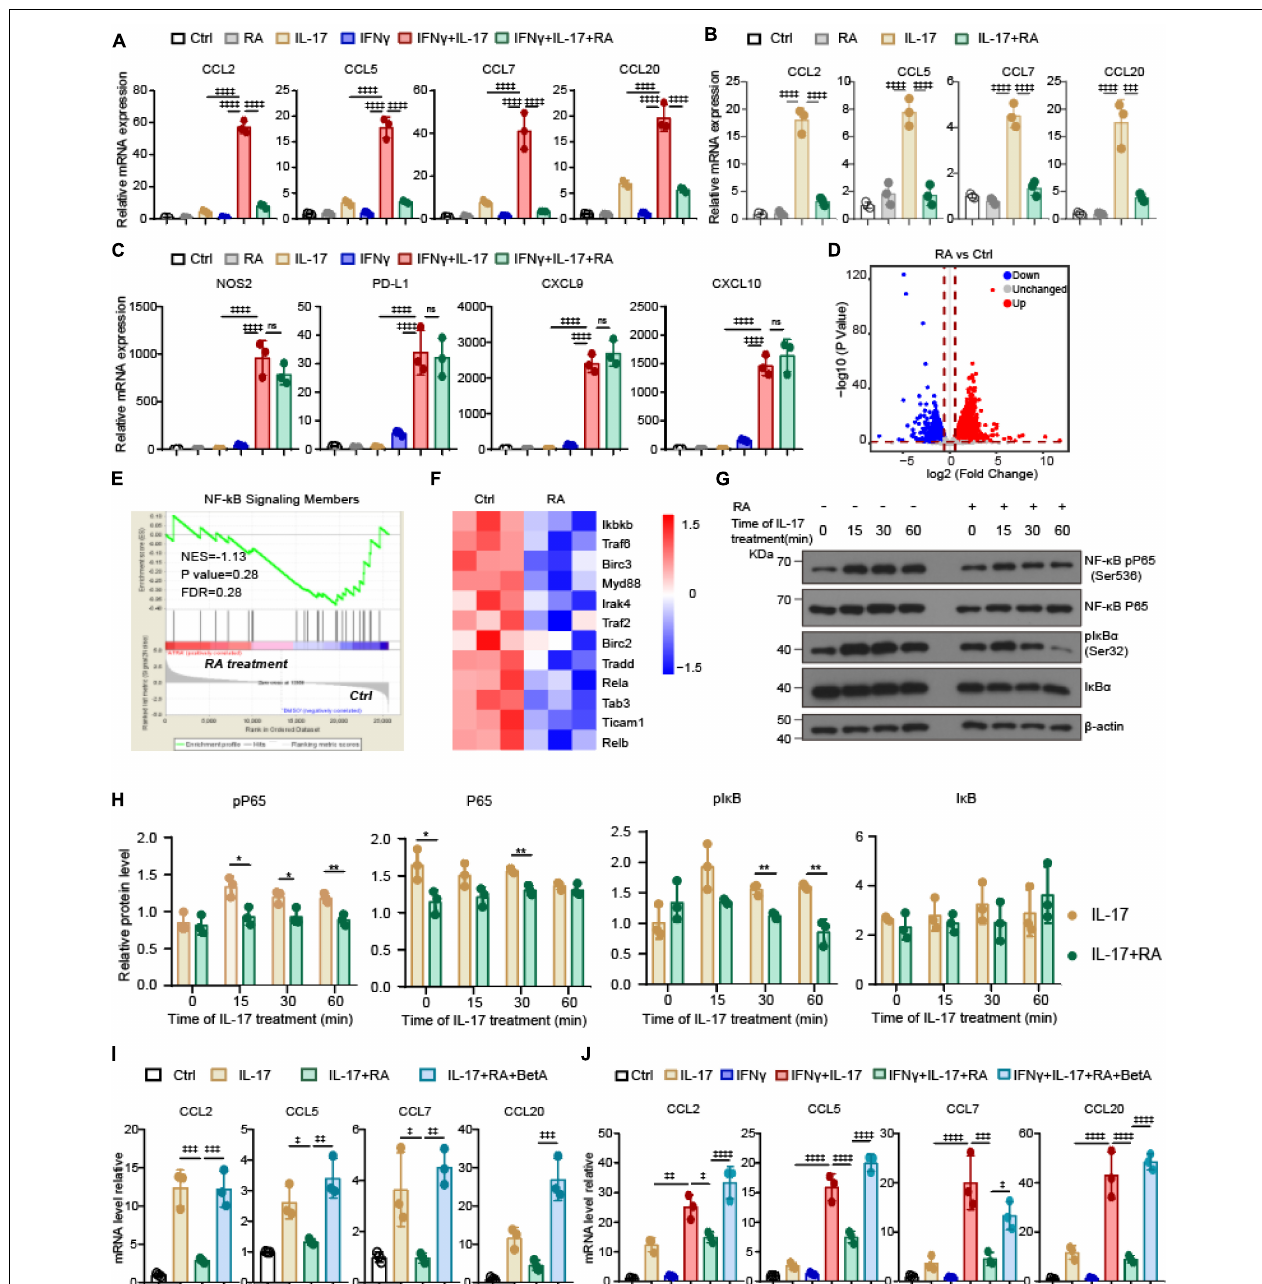
FIGURE 4 | RA inhibits IL-17-stimulated myelocyte-recruiting chemokine expression in BMSCs through inhibiting NF- κ B signaling pathway. (A) The relative mRNA expression level of myelocyte-recruiting chemokines (CCL2, CCL5, CCL7, and CCL20) in the IL-17 and IFN γ pre-treated BMSCs with or without RA treatment as indicated. (B) The relative mRNA expression level of myelocyte-recruiting chemokines in the BMSCs after IL-17 treatment with or without the RA treatment as indicated. (C) The relative mRNA expression level of immunoregulatory molecules (NOS2, PD-L1, CXCL9, and CXCL10) in the IL-17 and IFN γ pre-treated BMSCs with or without RA treatment as indicated. (D) Volcano plots illustrating the biological and statistical significance of genes between BMSCs with and without RA treatment. Upregulated genes are highlighted in red, unchanged genes are highlighted in gray, and downregulated genes are highlighted in blue. (E) Signature enrichment plots from GSEA using NF- κ B pathway gene-set in BMSCs treated with and without RA. The enriched p -value is derived from Fisher’s exact test. (F) A heatmap revealed NF- κ B-pathway gene expression changes after RA treatment in BMSCs. The rows show Z -scores calculated for each gene. (G,H) Immunoblotting analysis of key NF- κ B pathway elements in the BMSCs exposed to IL-17 with or without the RA treatment as indicated. (I) The relative mRNA expression of myelocyte-recruiting chemokines in BMSCs treated by IL-17, RA, and BetA as indicated. (J) The relative mRNA expression of myelocyte-recruiting chemokines in BMSCs treated by IFN γ , IL-17, RA, and BetA as indicated. Data represent mean ± SD of 3 independent experiments. * or ‡ p < 0.05, ** or ‡‡ p < 0.01, ‡‡‡ p < 0.001, ‡‡‡‡ p < 0.0001. ns, not significant.